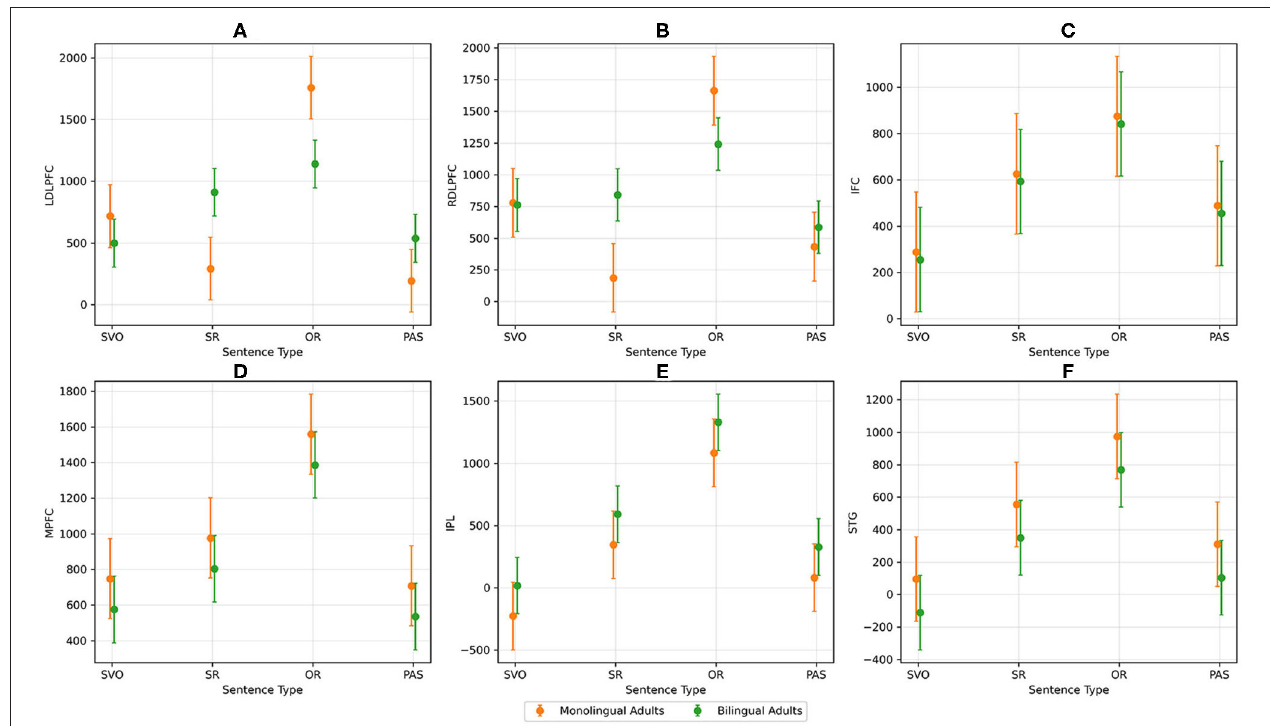
FIGURE 4 | AUC activation for each ROI and sentence type between monolingual and bilingual adults. Picture (A) shows the AUC activation for left DLPFC, (B) shows the AUC activation for right DLPFC, (C) shows the AUC activation for left IFC, (D) shows the AUC activation for MPFC, (E) shows the AUC activation for left IPL, and (F) shows the AUC activation for left